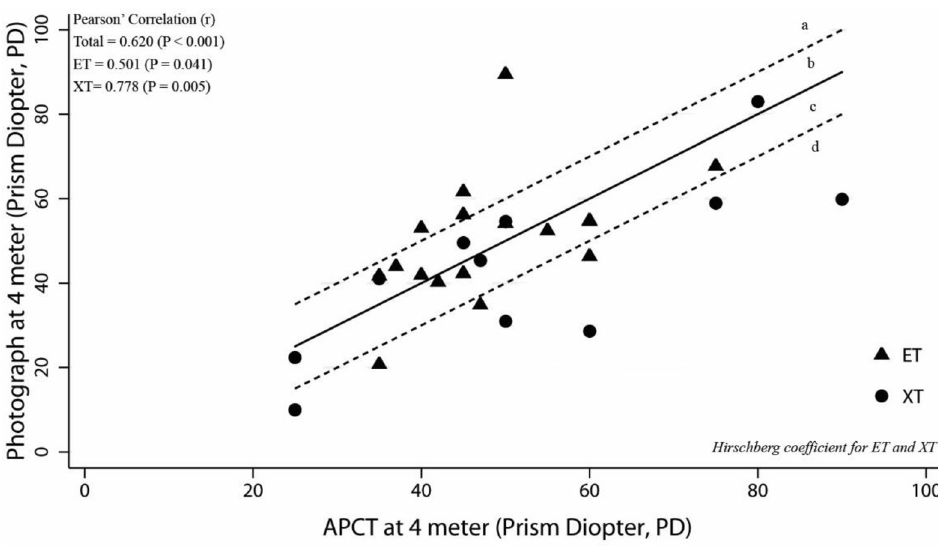
Fig 5. The relationship between angle of deviation from the Photo-Hirschberg test with APCT at D. The solid line is the line of equality and the zone between dotted lines represents range ± 10 PD of the APCT values. The acceptable area were b and c. The unacceptable area were a and d. (ET = esotropia; XT =